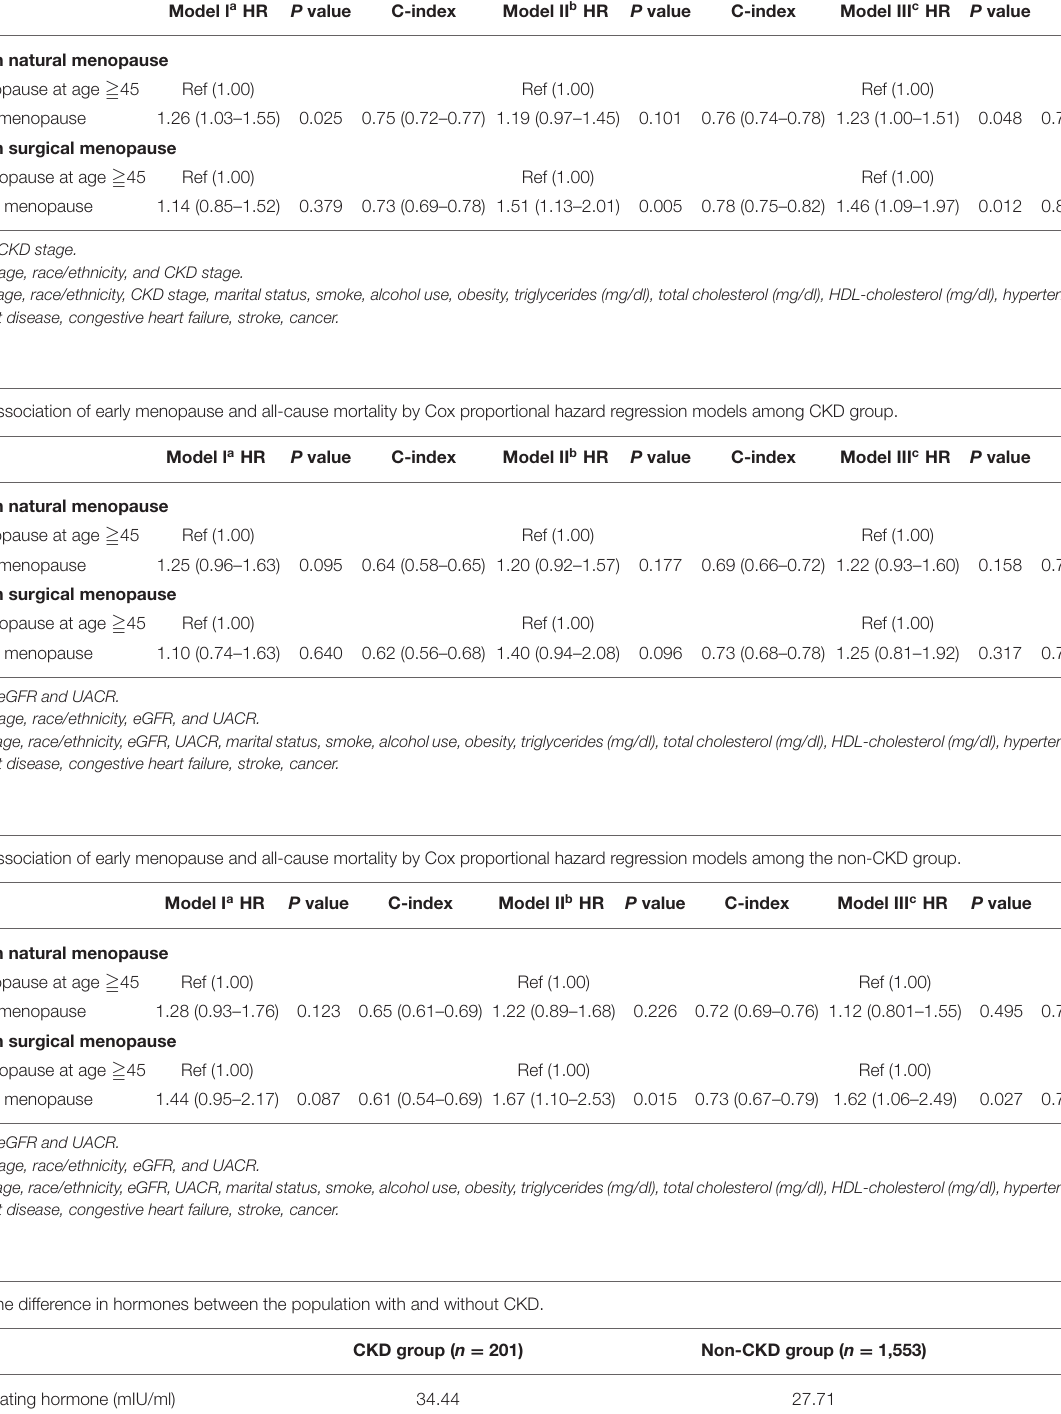
TABLE 3 | Association of early menopause and all-cause mortality by Cox proportional hazard regression models. Groups